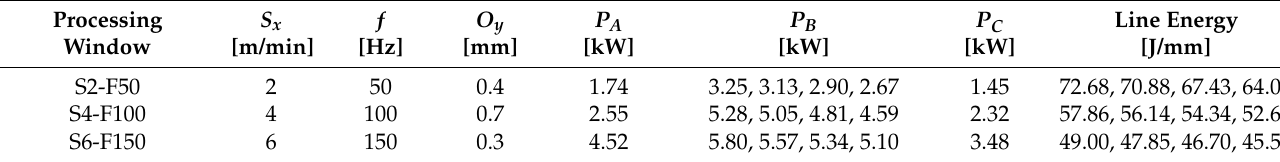
Figure 2. Representative weld cross-sections in the individual processing window ( a ) S2-F50, ( b ) S4-F100 and ( c ) S6-F150. Table 2. Matrix of process parameters used in this paper.